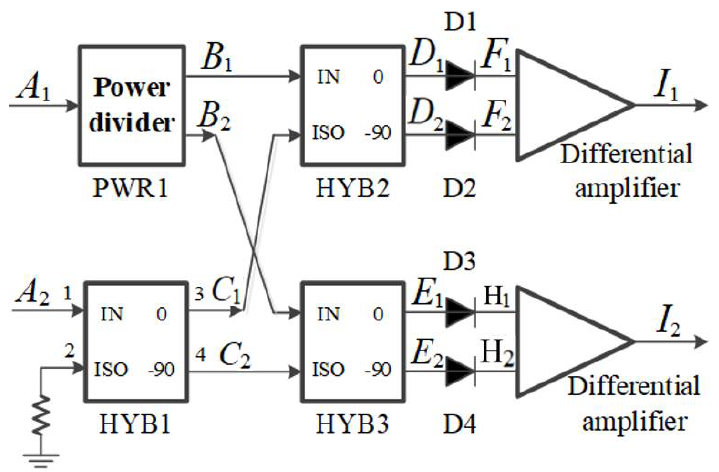
Figure 12. Schematic block diagram of an additive analog complex correlator.